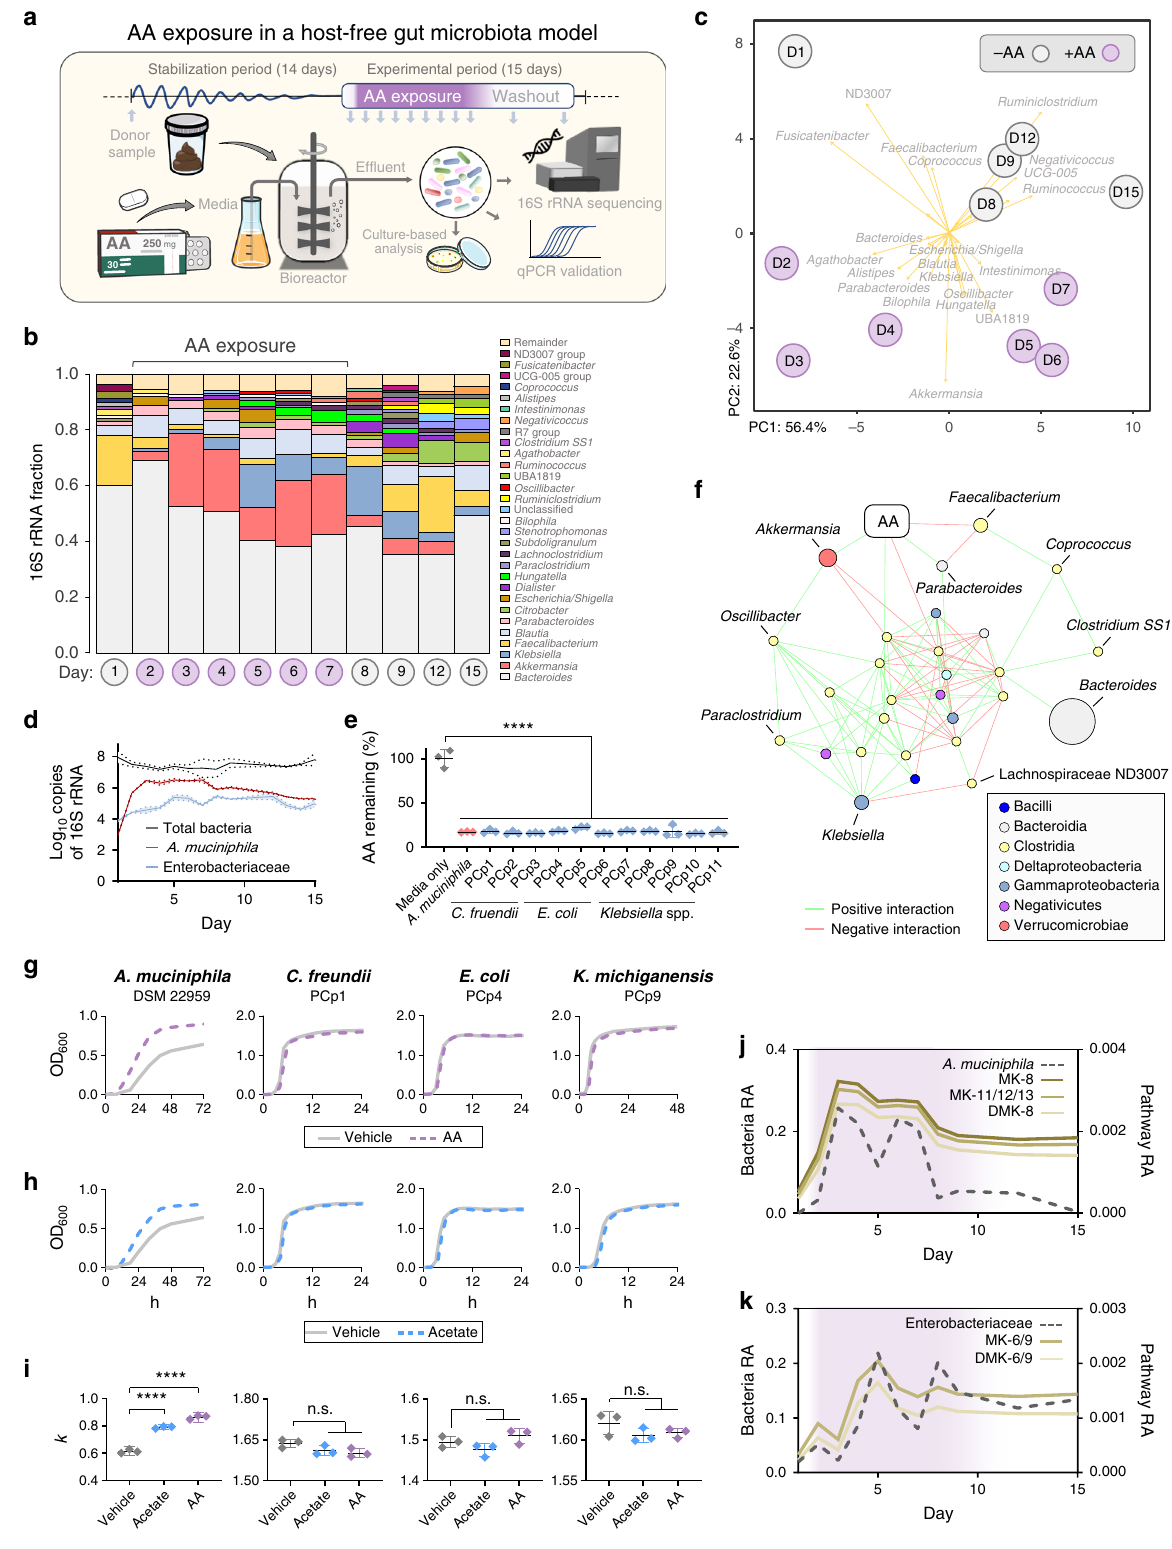
Supplementary Table 5, and Supplementary Data 2 – 6). In addi- tion, four pathways related to mycolic acid biosynthesis were nearly undetectable in both ADT and ADT + AA patient samples compared to controls (Supplementary Fig.